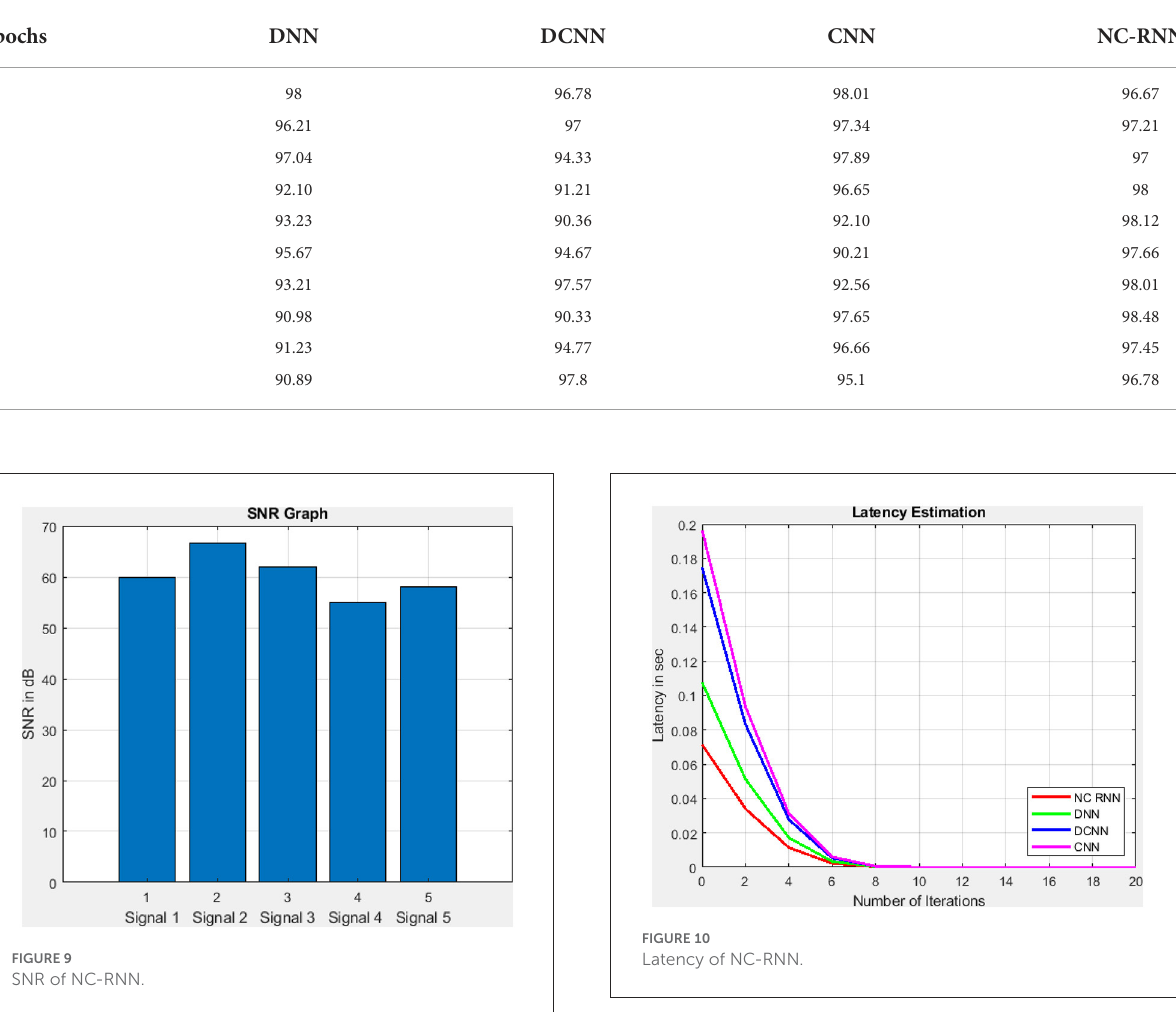
TABLE 1 Precision of NC-RNN.